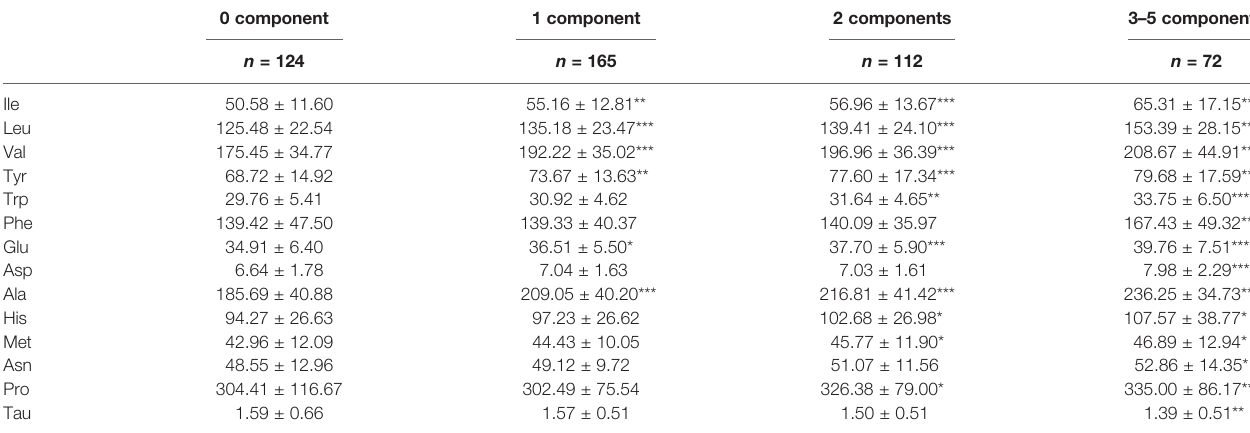
TABLE 3 | Amino acid association with MetS components.